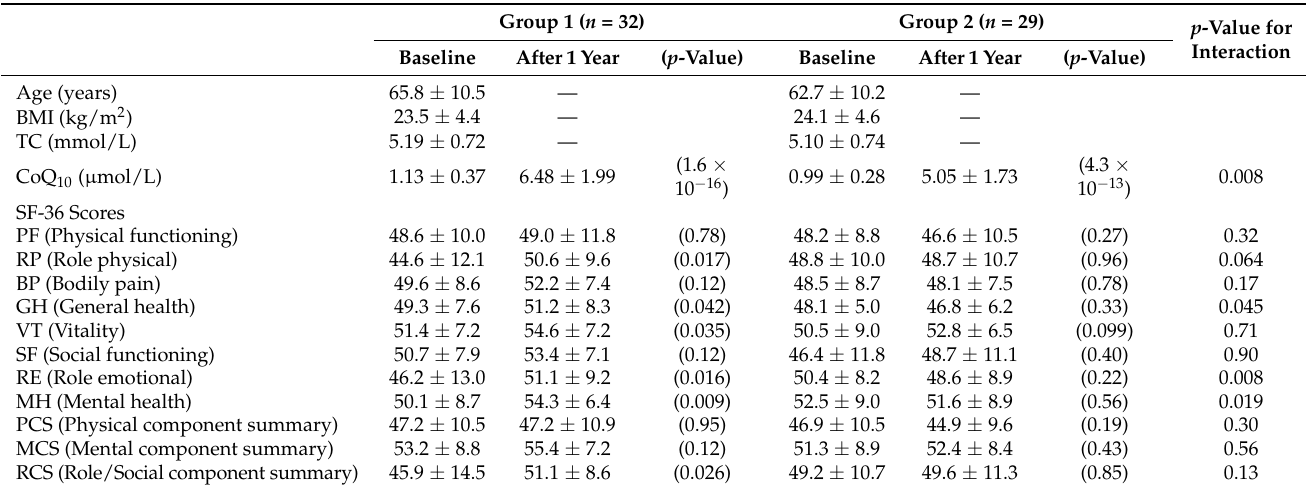
Table 6. Changes in the measurements of Group 1 and Group 2 during the reduced CoQ 10 supple- mentation in